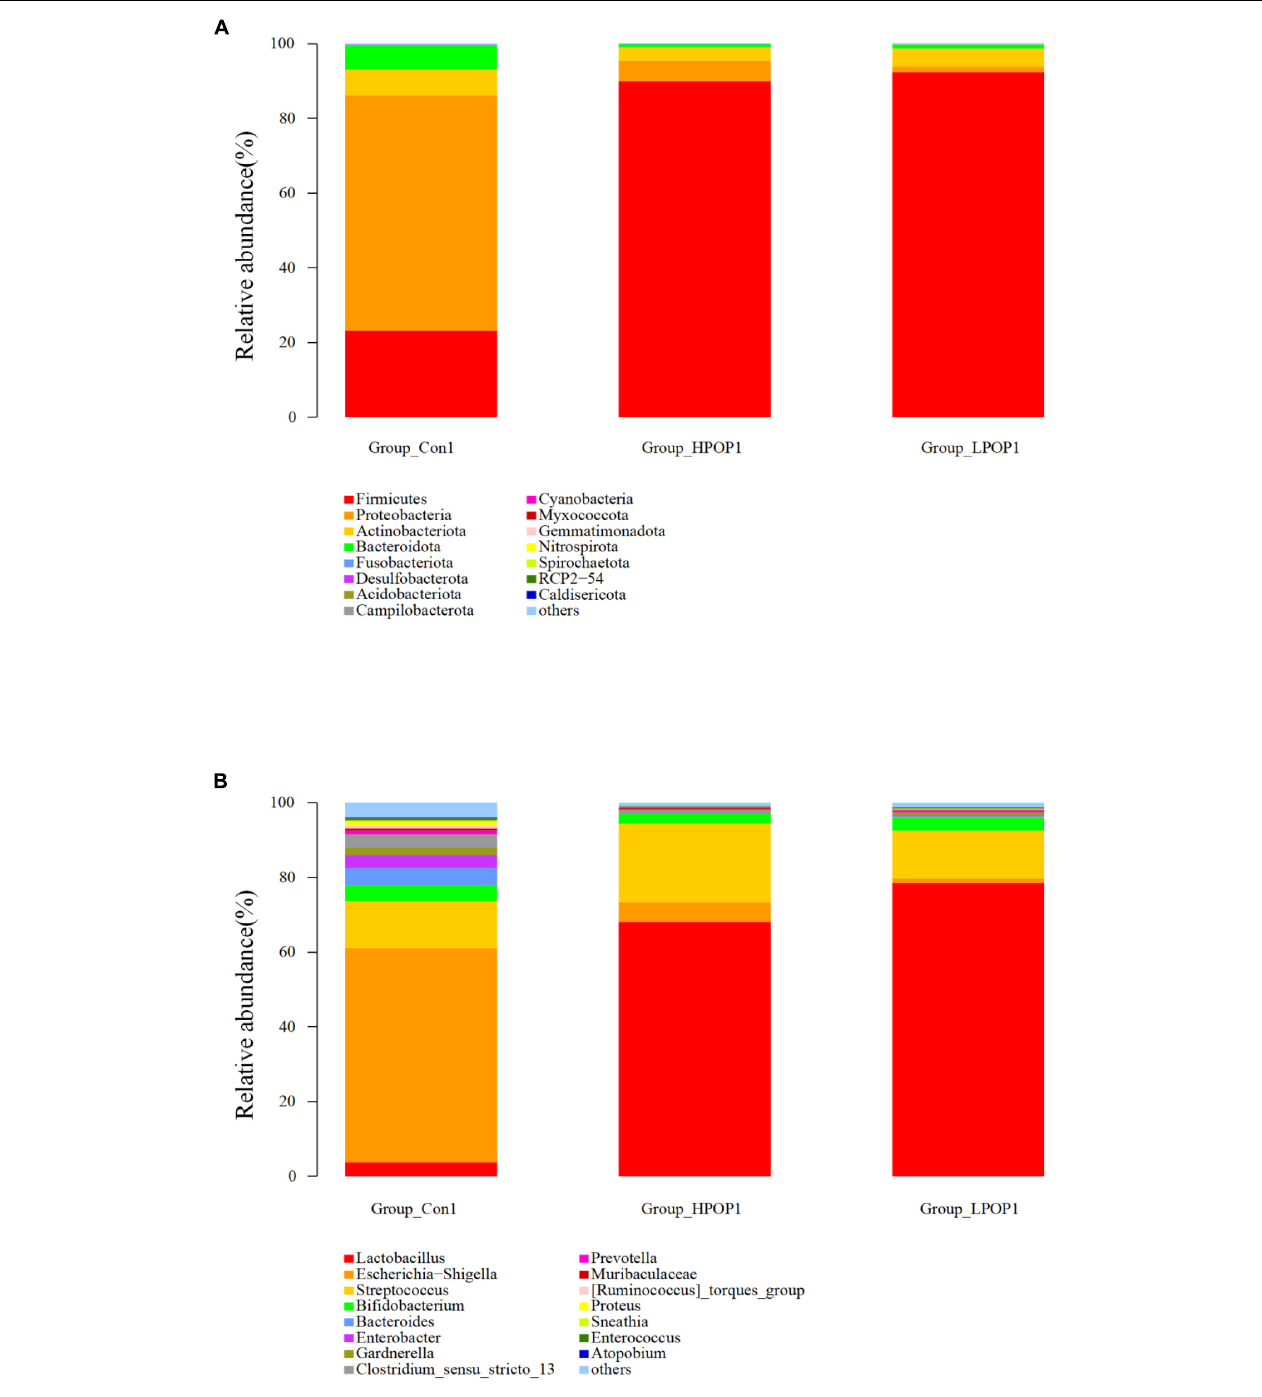
FIGURE 4 | Effects of POP on microbial composition of the fermentation (phylum and genus levels). Changes of microbiota composition at phylum (A) and genus (B) levels at 24 h in vitro fecal fermentation with POP.